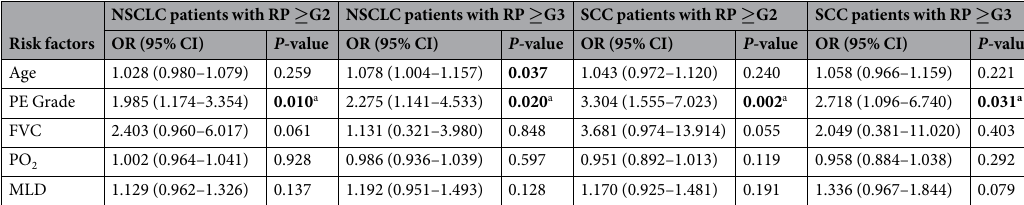
Table 4. Unconditional logistic analysis of possible risk factors associated with the development of RP. a P for the trend of grade 0, Grade 1 and Grade ≥ 2; RP, radiation pneumonitis; OR, odds ratio; NSCLC, non-small cell lung cancer; SCC, squamous cell carcinoma; G2, Grade 2; G3, Grade 3; PE, pulmonary emphysema; FVC, forced vital capacity; PO 2 , arterial partial pressure of oxygen; MLD, mean lung dose. Significant differences are indicated in